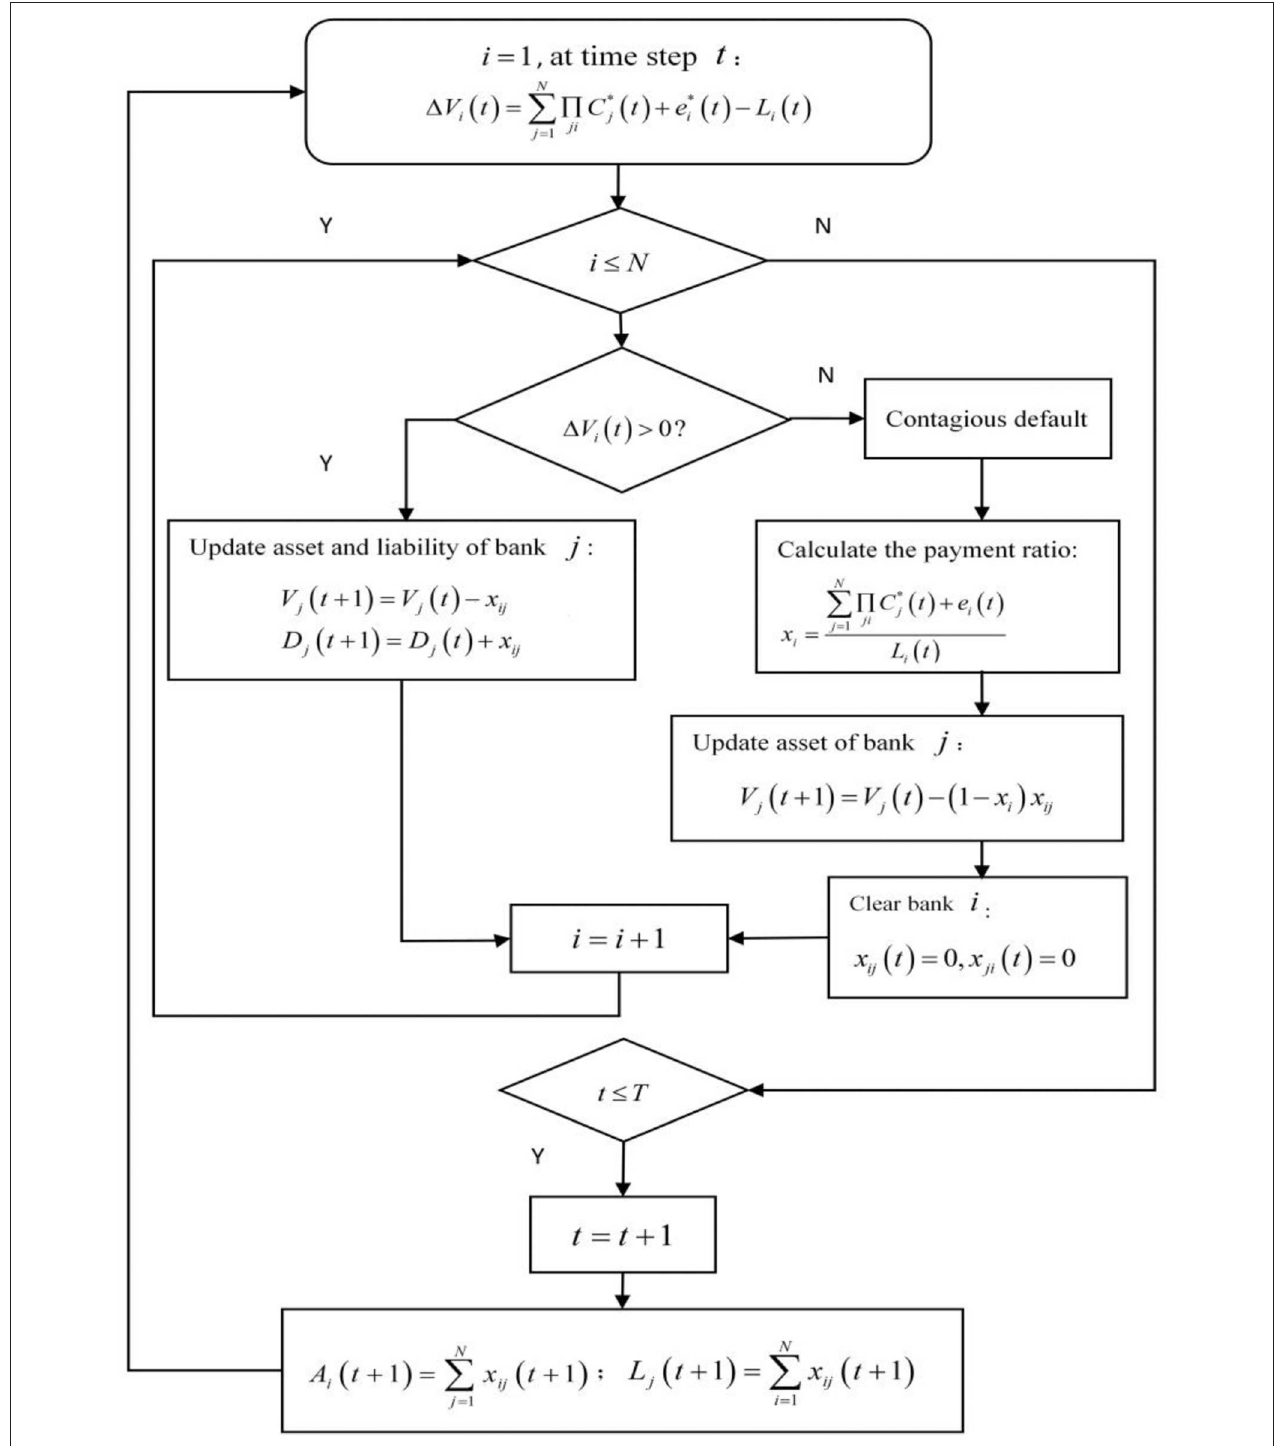
FIGURE 2 | Flow chart of dynamic evolution of interbank market network.